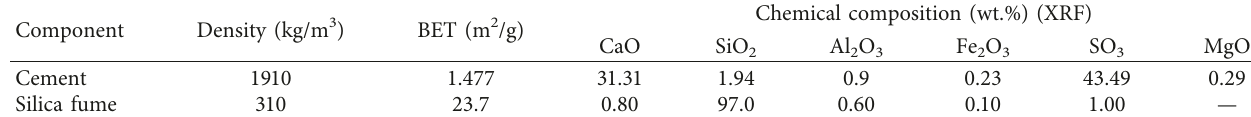
Table 1: Chemical composition and geometric characteristics of cement and silica fume.